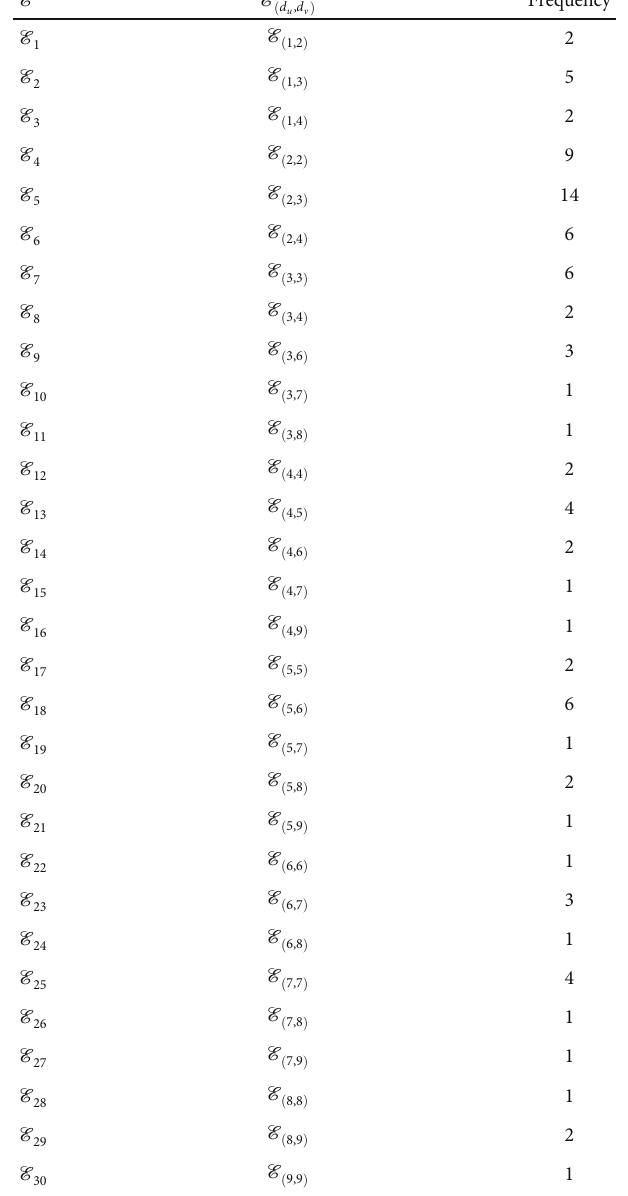
Table 1: Edge partitioning based on degree of Remdesivir